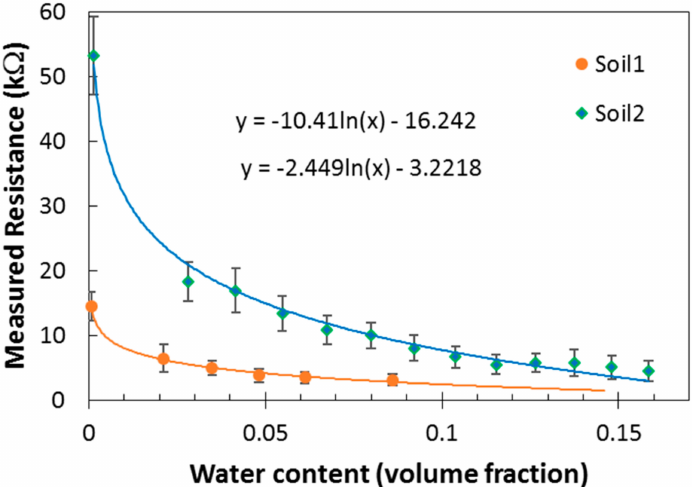
Figure 5. The graph of soil resistance versus water content measured for two different soil types at 19 ◦ C temperature. The logarithmic fit to the measured data is shown by two equations. Soil 1 initially contained more fertilizer, resulting in lower resistance values. Two electrodes with an area of 7.35 cm 2 were placed 30 cm apart during this